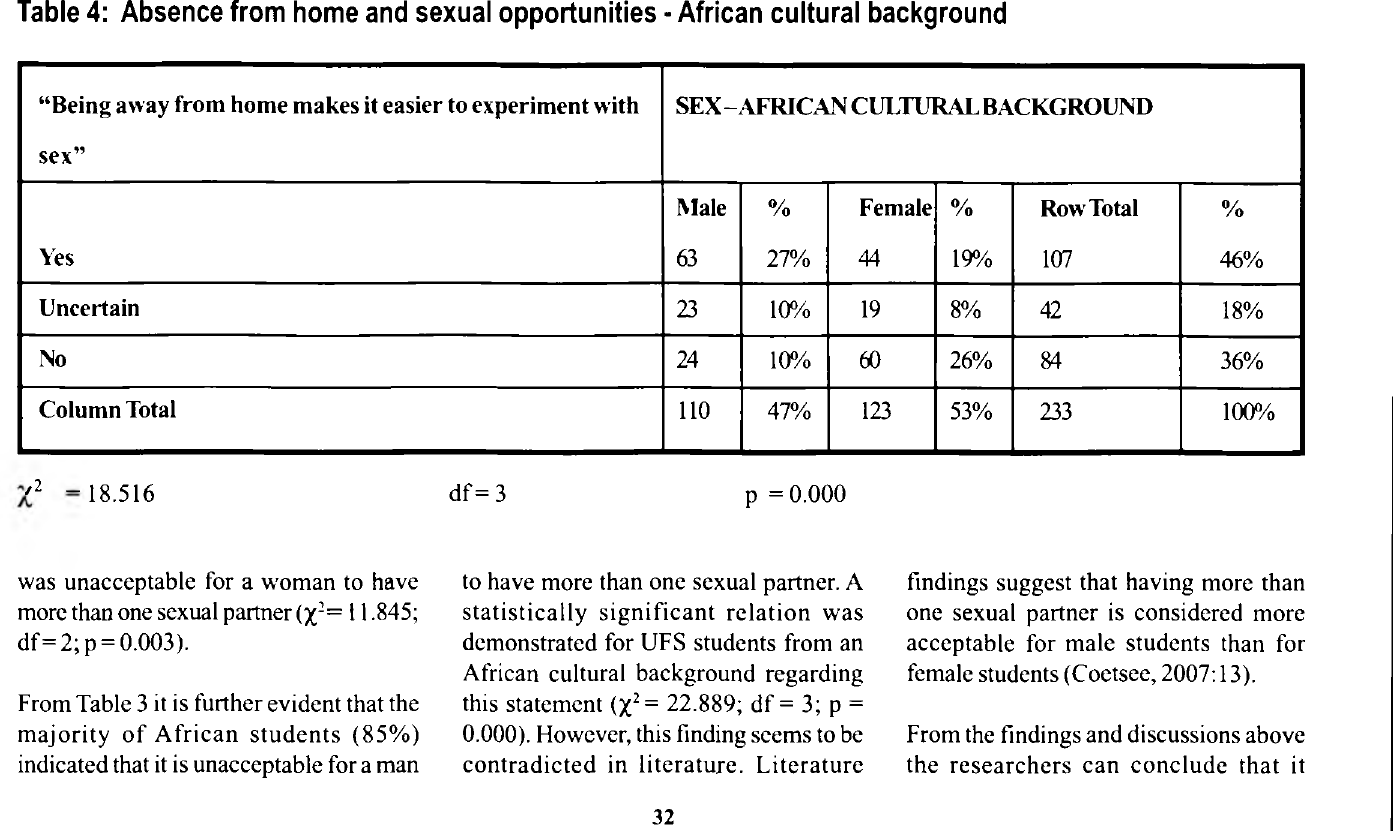
Table 4: Absence from home and sexual opportunities - African cultural background “Being away from home makes it easier to experiment with